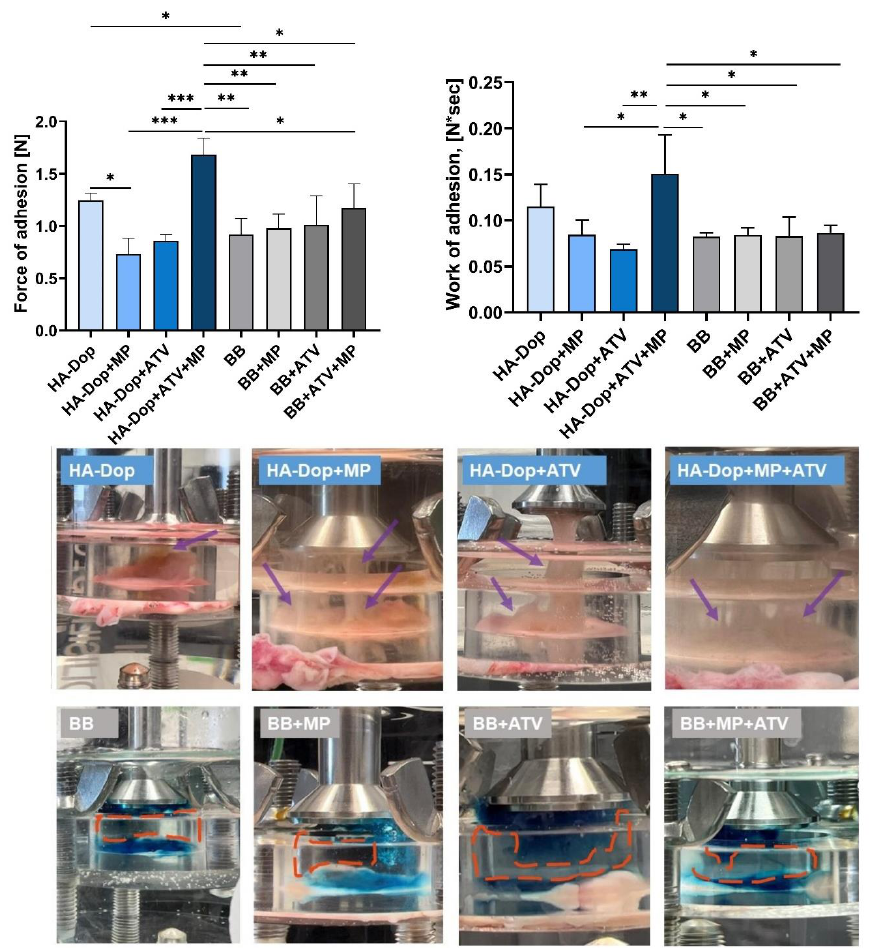
Figure 4. Upper panel, left: maximum of the force of adhesion [N] of the HA-Dop and control formulations, measured with texture analyzer. Right: work of adhesion [N*sec] of the formulations. All row means were analyzed by one-way ANOVA and unpaired two-tailed t -tests. Bottom panel: photos, taken a few seconds after the detachment of the probe. N = 3, error bars = SD, *p ≤ 0.05; **: p ≤ 0.01; ***: p ≤ 0.001 .